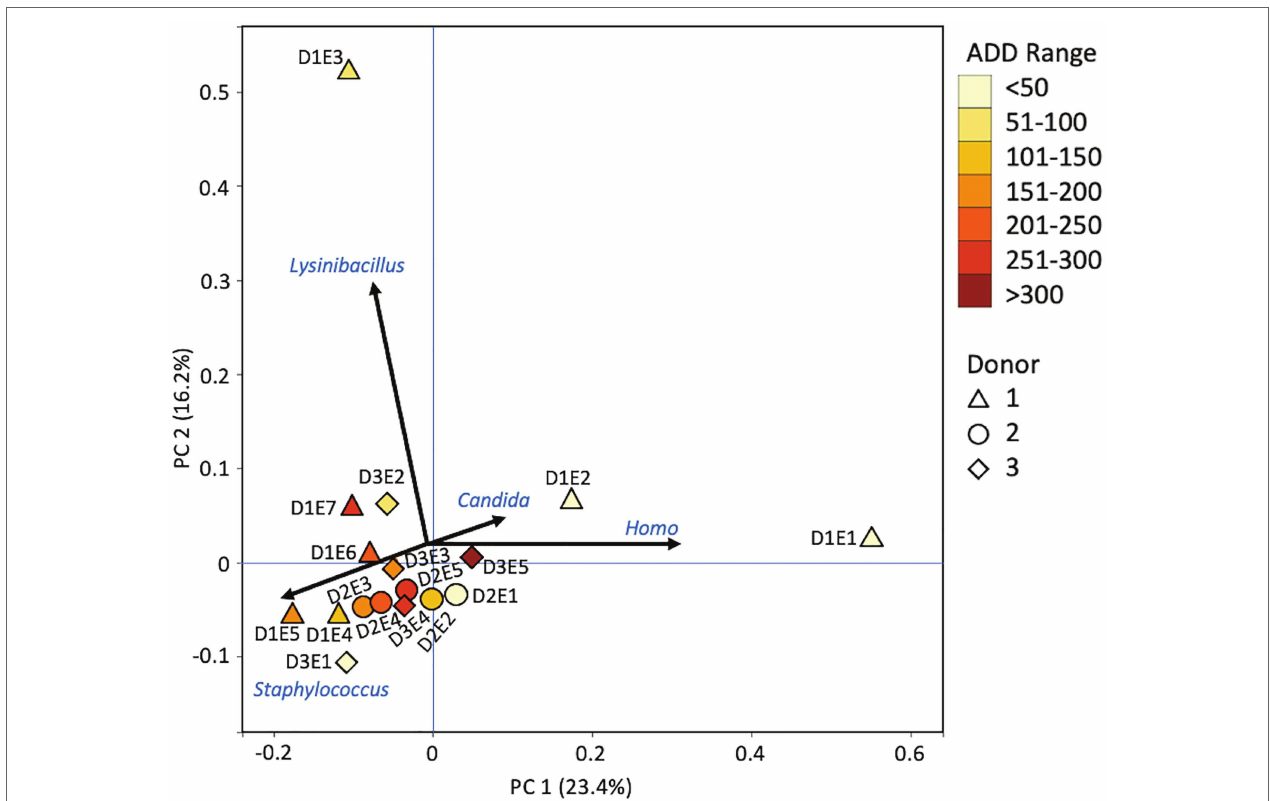
FIGURE 13 | Principal components analysis plot for the proportional data of bacterial and eukaryotic genera observed from shotgun MetaT sequencing from oral samples of three human donors (Donors 1, 2, and 3) during decomposition. Shading is added to the symbols [triangles for Donor 1 (D1), circles for Donor 2 (D2), and diamonds for Donor 3 (D3)] to show earlier (lighter shading) to later (darker shading) ADD and also times sampled (from E1 to E7 for D1 and E1 to E5 for D2 and D3, indicating first sample to last sample